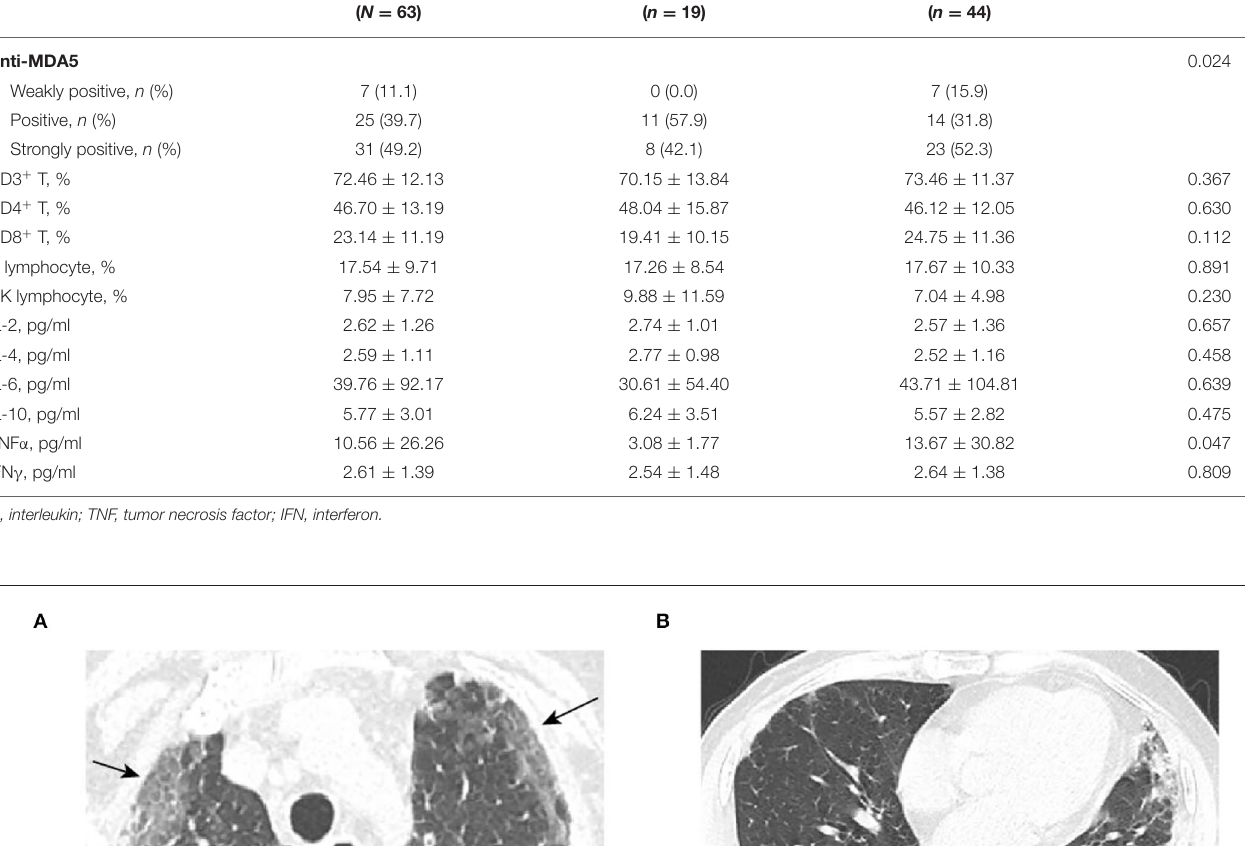
TABLE 4 | Immunologic tests for MDA5 + DM-ILD. Characteristics